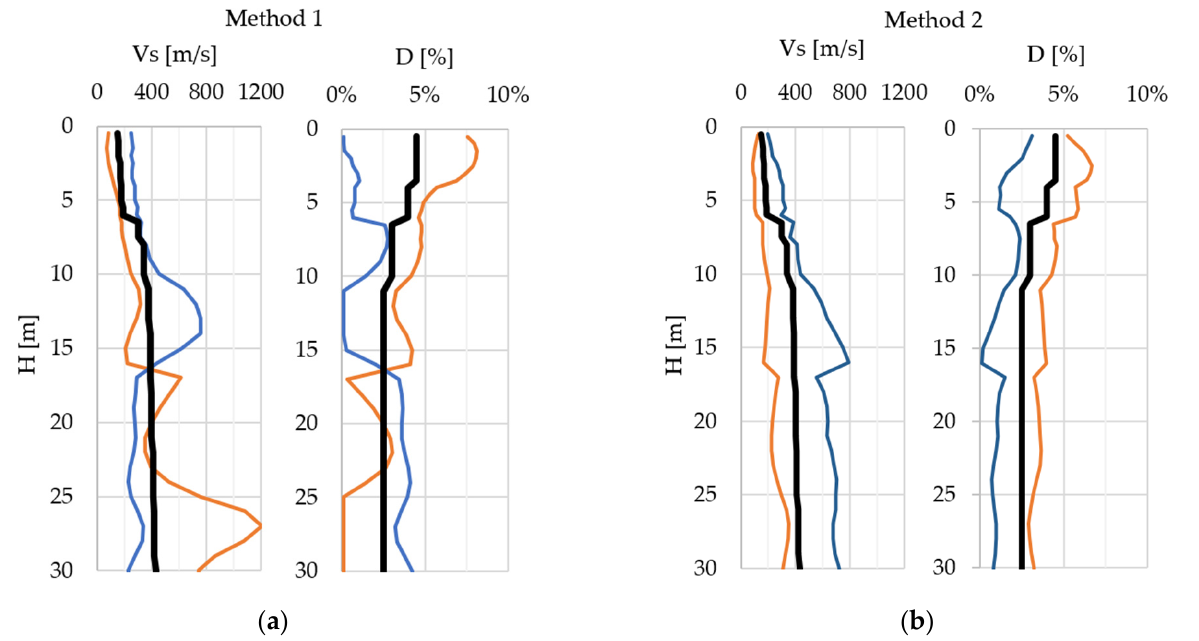
Figure 13. Example of generated soil profiles using ( a ) Method 1 and ( b ) Method 2.